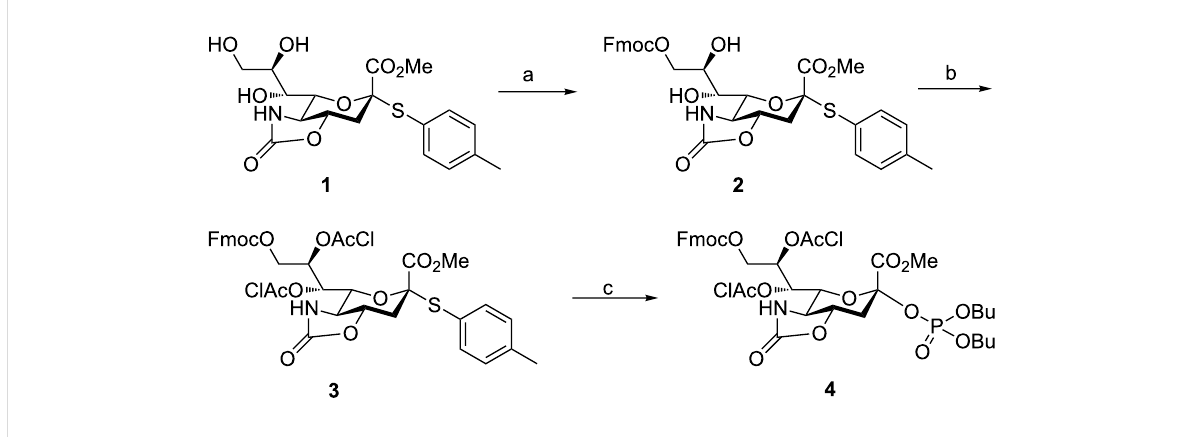
Scheme 1: (a) FmocCl, py, CH 2 Cl 2 , rt, 4 h, 77%, (b) 2-chloroacetyl chloride, py, CH 2 Cl 2 , 0 °C to rt, 3 h, 88%, (c) HOPO(OBu) 2 , NIS, TfOH, 4 Å MS, CH 3 CN/CH 2 Cl 2 , − 78 °C to 0 °C, 2 h,